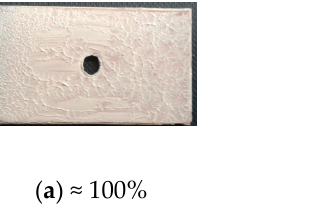
Figure 13. Configuration of thermal grease with different area.